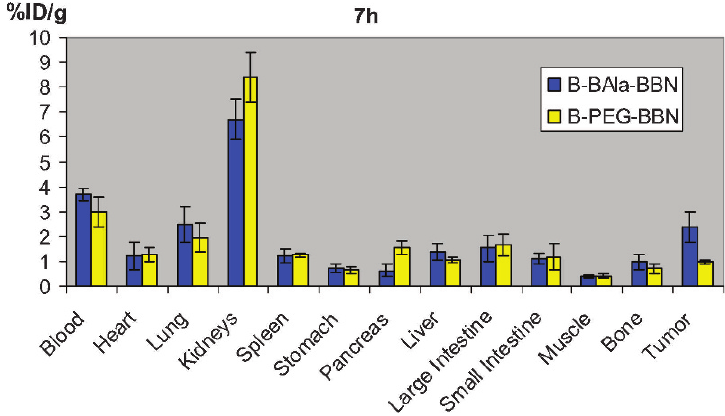
Figure 8 - Biodistribution of (SA + B-MORF + B - b Ala -BBN) and (SA + B-MORF + B -PEG -BBN) (7 h post injection) plus 99m Tc-MAG 3 -cMORF (2 h post injection) by pretargeting system in Nude mice bearing tumor